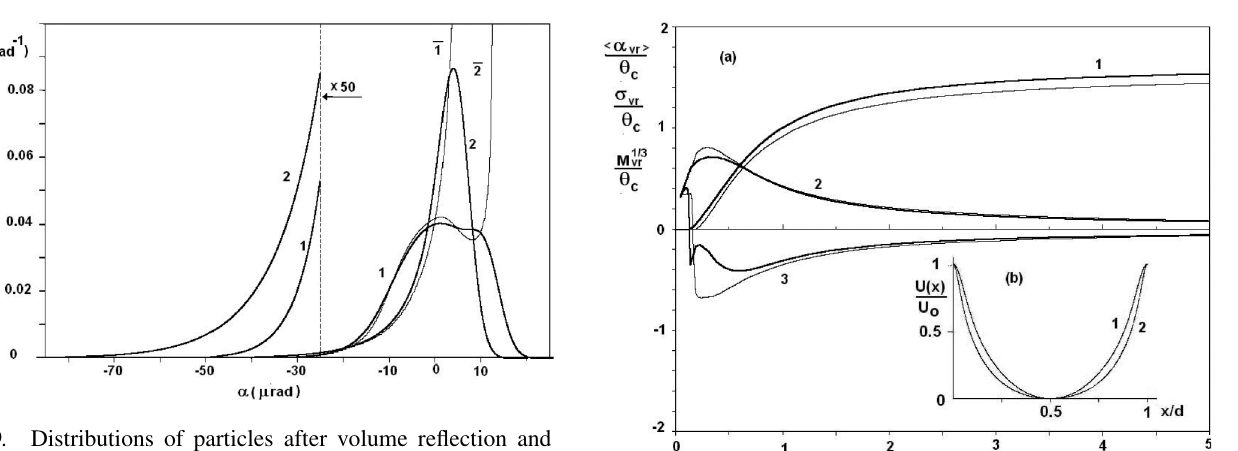
i =(cid:4) =(cid:4) , (cid:10) , and M 1 = 3 vr =(cid:4) as vr c vr c c of 0